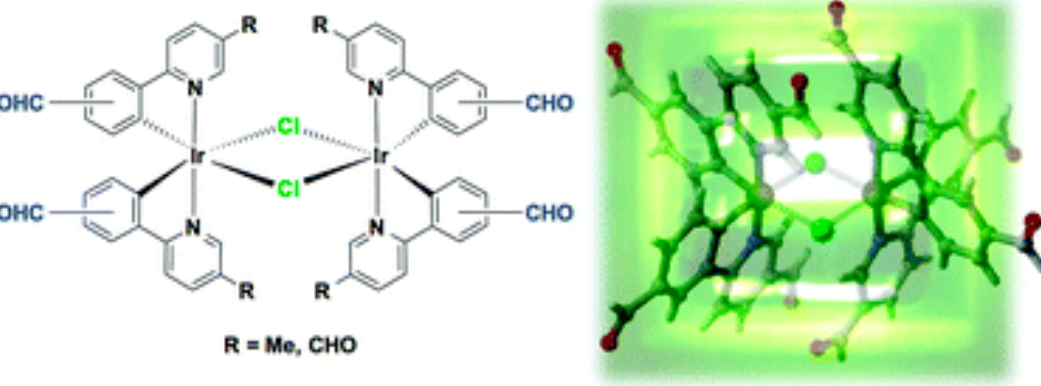
Figure 9. Chemical and crystal structure of diiridium cyclometalated complex with functionalized formyl group [92]. [(Wong et al.). Copyright reproduced with permission from Royal Society of Chemistry